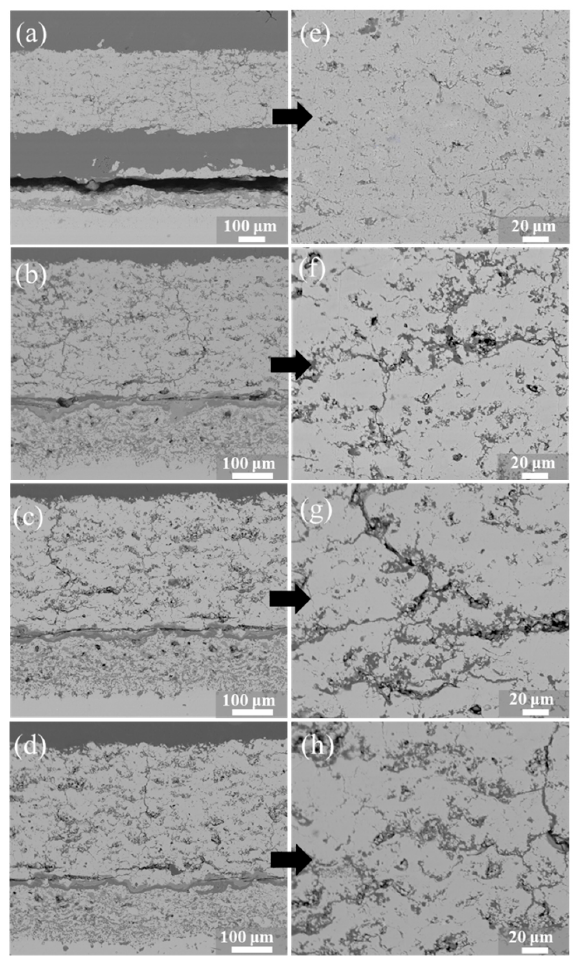
Figure 13. Cross-sectional microstructure of the TBCs after thermal cycle test: ( a , e ) conventional TBC, ( b , f ) EMAP TBC (d = 35 mm, 12 g/min + 16 g/min), ( c , g ) EMAP TBC (d = 40 mm, 12 g/min + 16 g/min), and ( d , h ) EMAP TBC (d = 35 mm, 16 g/min + 16 g/min).